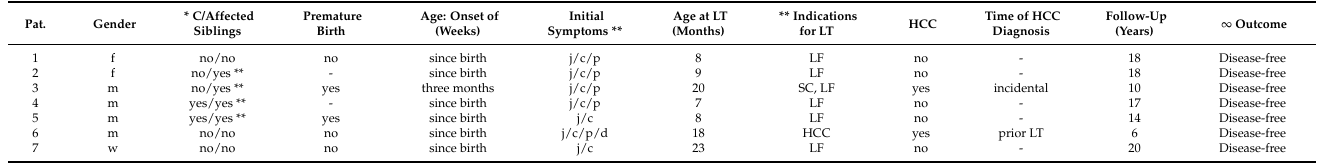
Table 1. Patient characteristics and demographic